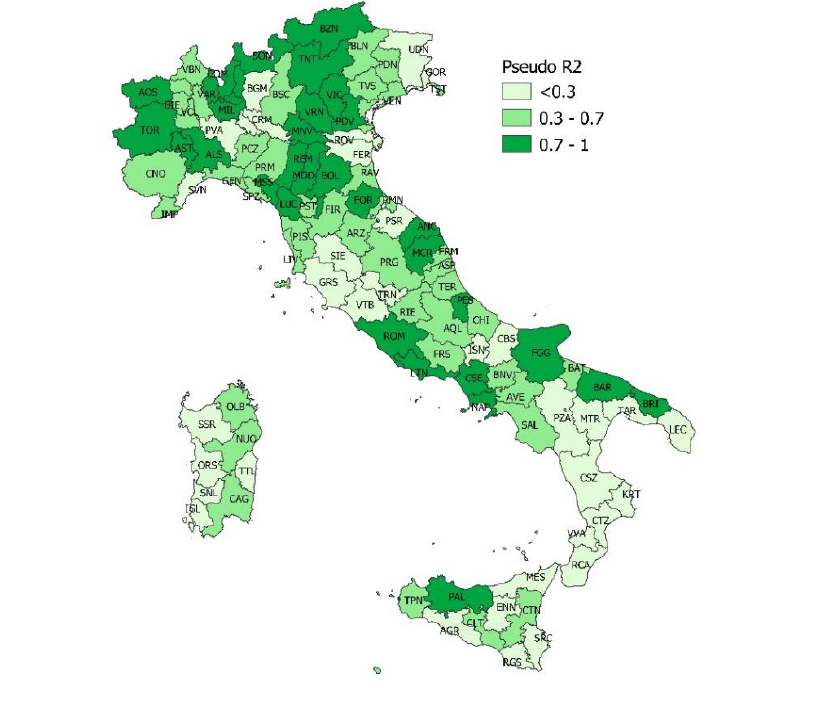
Figure 14. Pseudo R2 values of Italian